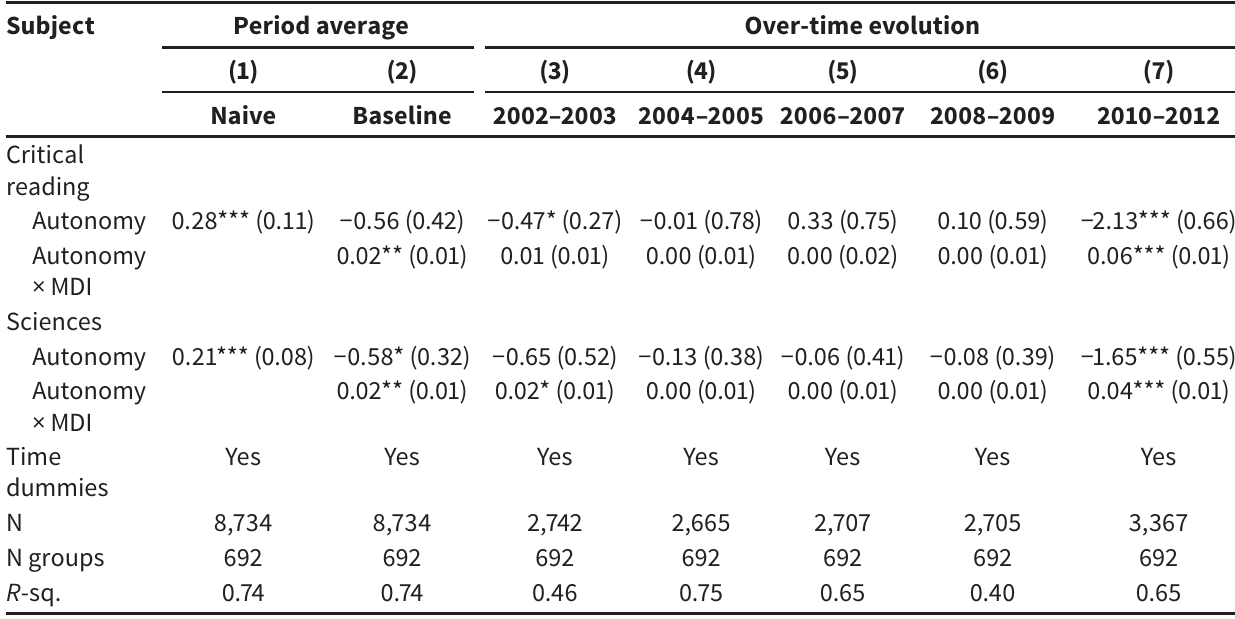
The effect of municipal autonomy on test scores – other subjects